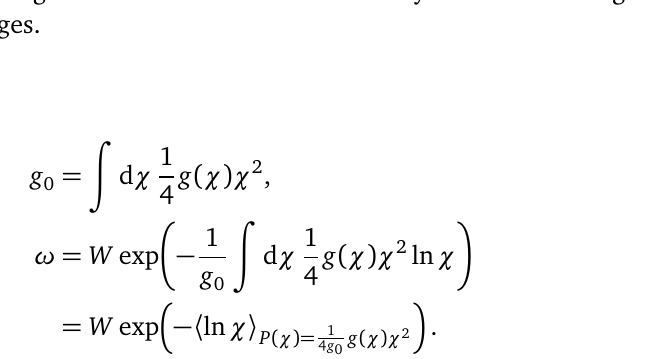
Figure 6: The density of states g ( (cid:34) , χ ) [ Eq. (29) ] as a function of the single-particle = − ∆ energy (cid:34) and gap function χ for our model [ Eq. (18) ] when ∆ (which occurs x y = + ∆ when µ/ t (cid:48) < 0). The ∆ case is obtained by reflecting (cid:34) + µ → − (cid:34) − µ . The x y density of states g ( (cid:34) ) as a function of only the single-particle energy (cid:34) is shown in Fig. 3. The grayscale legend should not be taken seriously at the bottom-right corner where g ( (cid:34) , χ )